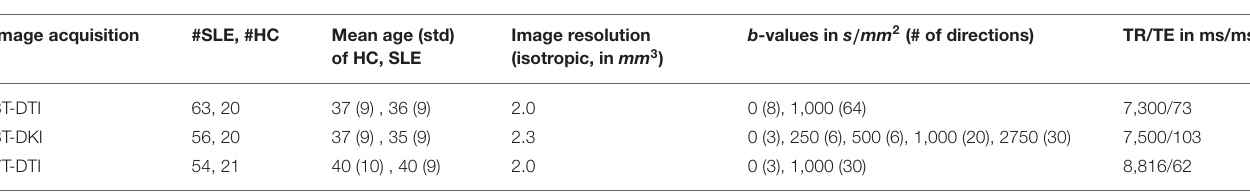
TABLE 1 | Demographics and image acquisition parameters.